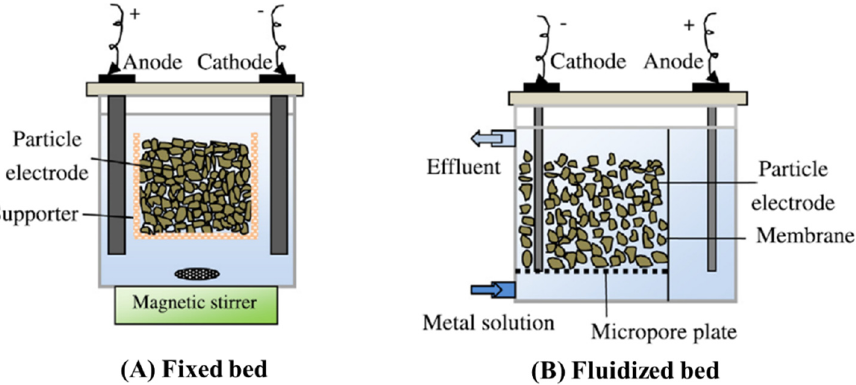
Figure 6. Scheme of three-dimensional electrochemical systems with heterogeneous catalyst re- strained ( A ) or loosened ( B ) in solution as a bed in between the anode and the cathode (Reprinted from [68] with permission from Elsevier, License Number 5172360169697).